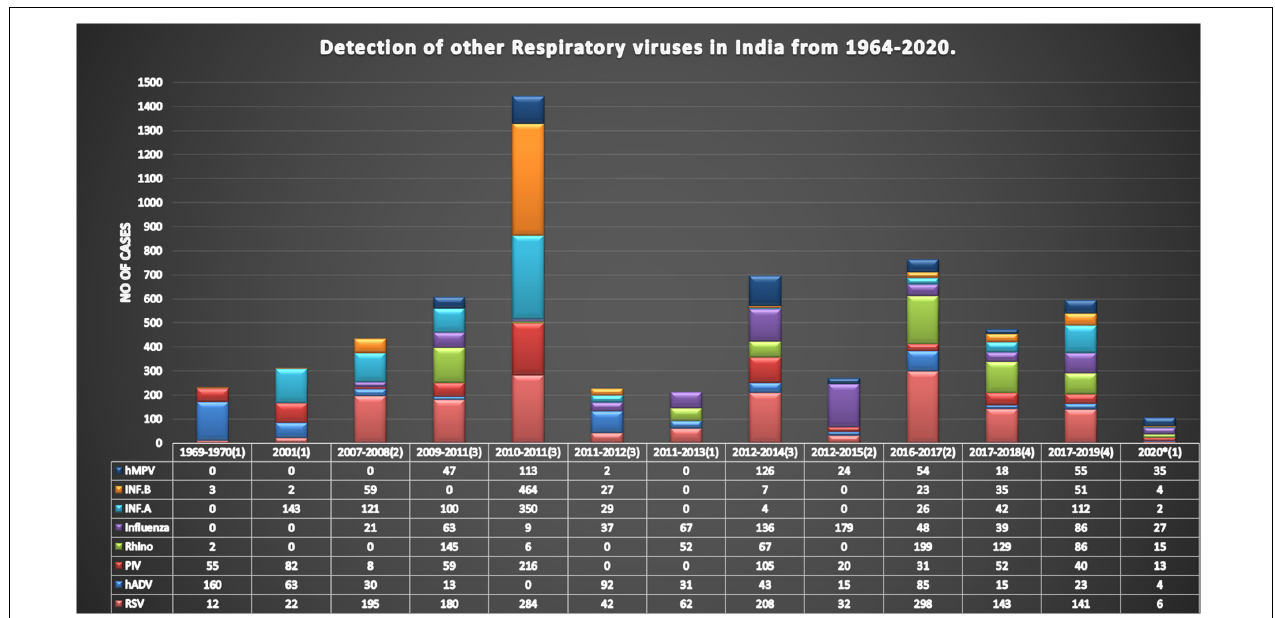
FIGURE 4 | Prevalence of respiratory viruses from 1969 to 2020 in India. This figure shows the total prevalence of respiratory viruses in India from 1969 to 2020. The number of cases is reported on the Y -axis and the year of reporting is presented on the X -axis, while the number in brackets indicates the number of papers published in that period, with papers published in the same year being merged. The tabular format below the graphical presentation includes the number of viruses studied along with the year-wise reported positive